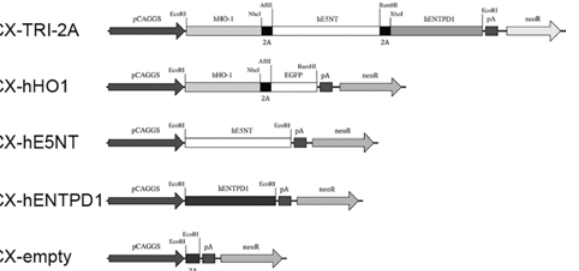
Fig 1. Schematic maps of tricistronic pCX-TRI-2A vector and all the constructs used in the work. The transgenic plasmid is composed of the CAGGS promoter, followed by the coding sequence of human HO-1 gene without the stop codon, fused in frame to the first F2A sequence (F2A), then the coding sequence of human E5NT gene without the stop codon, the second F2A sequence and the coding sequence of human ENTPD1 gene followed by a polyadenilation signal